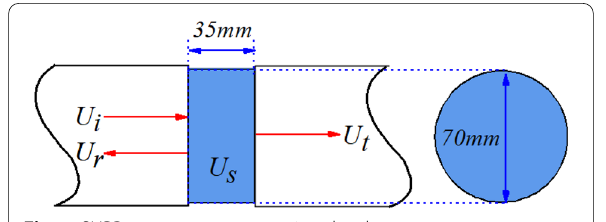
Fig. 5 SHPB test energy propagation sketch.